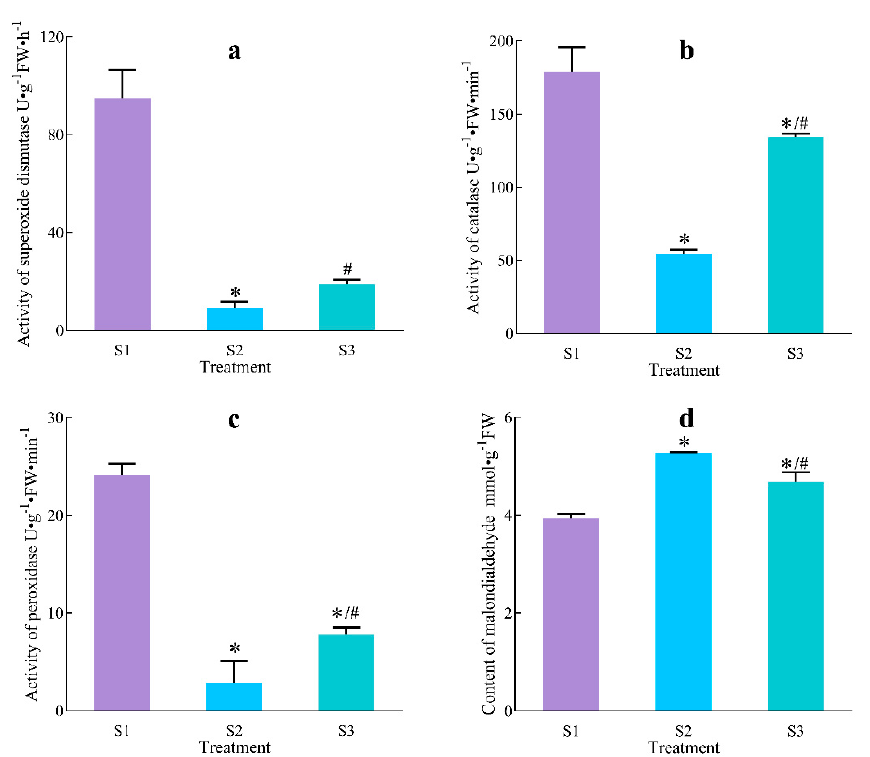
Figure 6. Oxidant-antioxidant parameters in the F. solani colony. ( a ) Superoxide dismutase (SOD). ( b ) Catalase (CAT). ( c ) Peroxidase (POD). ( d ) Malondialdehyde (MDA). S1 group ( n = 3), inoculation of F. solani on PDA; S2 group ( n = 3), inoculation of F. solani on PDA containing 40 µ mol/L DPI; S3 group ( n = 3), inoculation of F. solani on PDA containing 40 µ mol/L DPI. On the fourth day of cultivation, 5 mL of 0.0012% H 2 O 2 was added to each dish. Data are expressed as the mean ± SD. * p < 0.05 S2 or S3 vs. S1, # p < 0.05 S3 vs. S2.